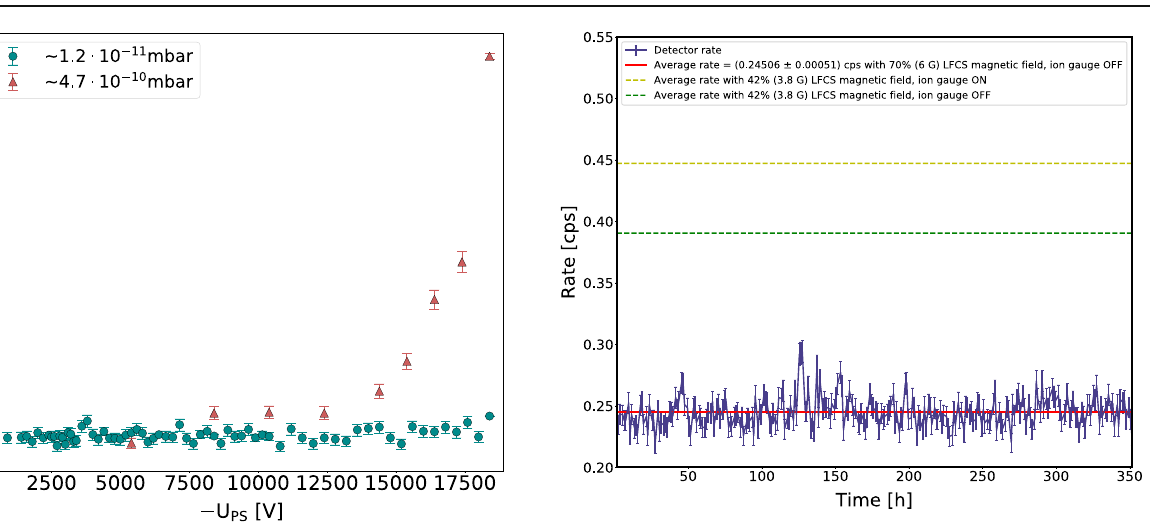
Fig. 11 Backgroundmeasurementsattwodifferentpressuresandvari- able U PS (setting C, Table 1). A strong increase of the background rate induced by the Penning trap manifests itself during the higher pressure measurements (red dots) for PS voltages more negative than − 14.4 kV, while for the lower pressure measurements (blue dots) the rate stays essentially unchanged for the whole range of U PS . For the measure- ment at increased pressure, the indicated pressure value is corrected for argon